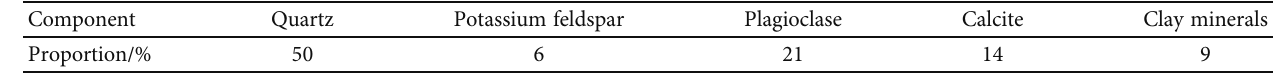
Table 2: The mineral composition of cores.